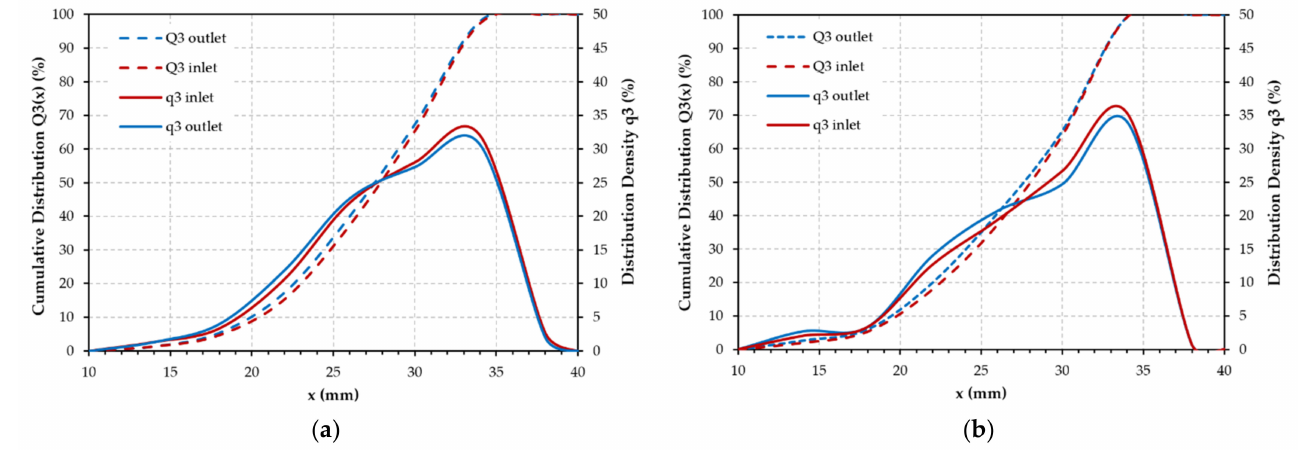
Figure 13. Pellets size change during cooling process: ( a ) Variant A; ( b ) Variant